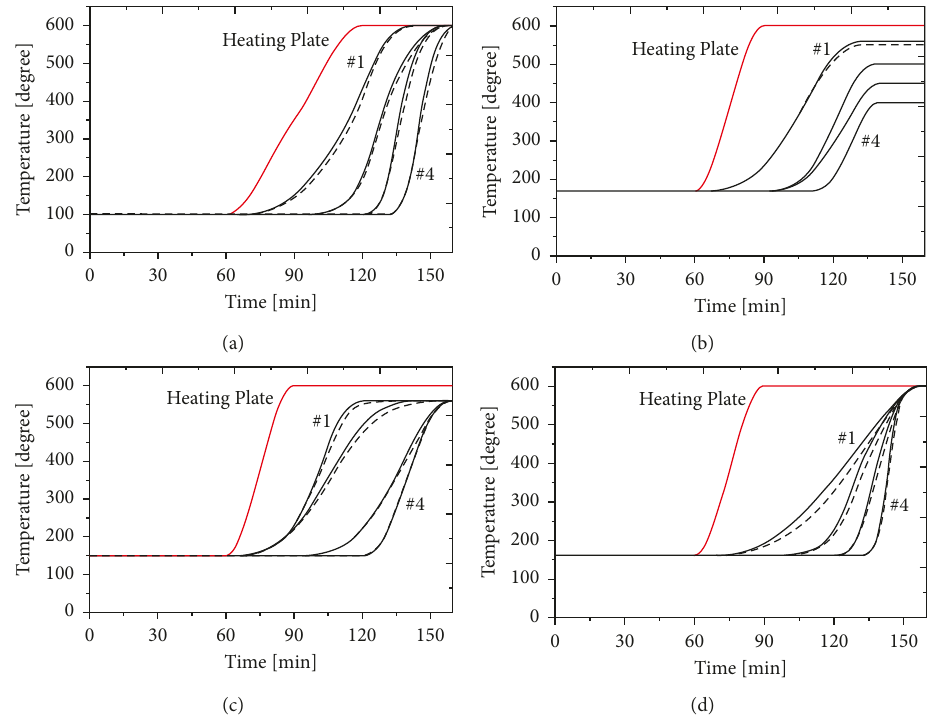
Figure 9: Temperature evolution of (a) N 0, (b) N 10, (c) N 30, and (d) P 20 specimens with time. Solid lines (experimental results) and dotted lines (evaluated temperature). Reddish colored line.